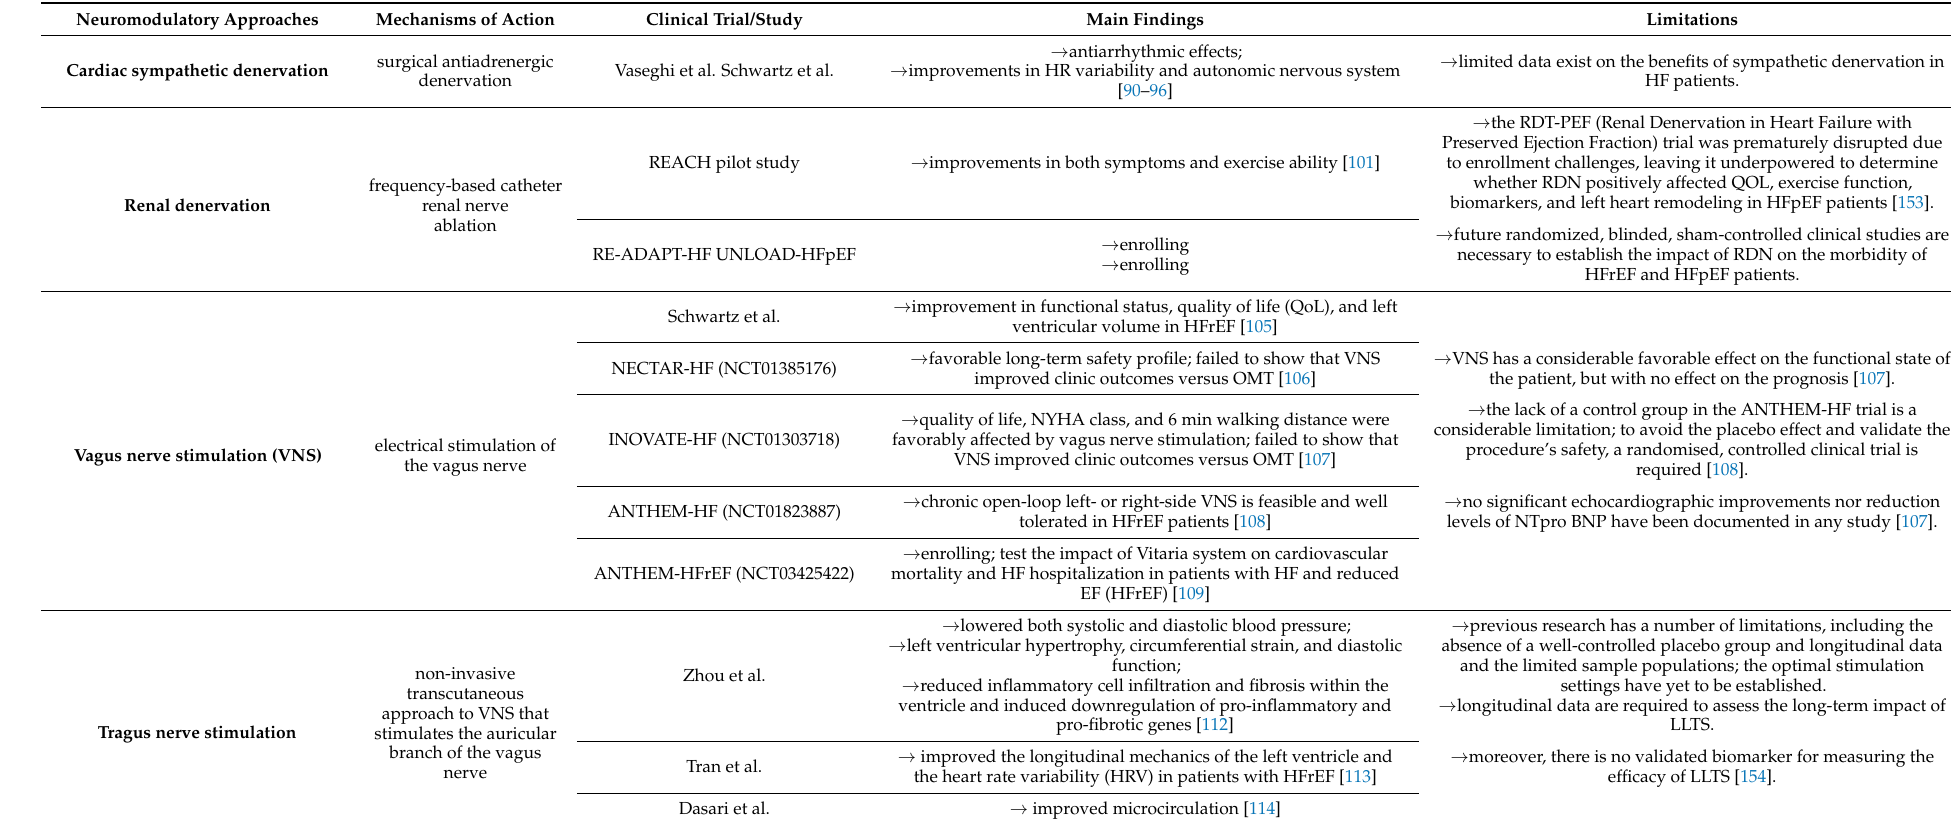
Table 2. Neuromodulatory approaches in